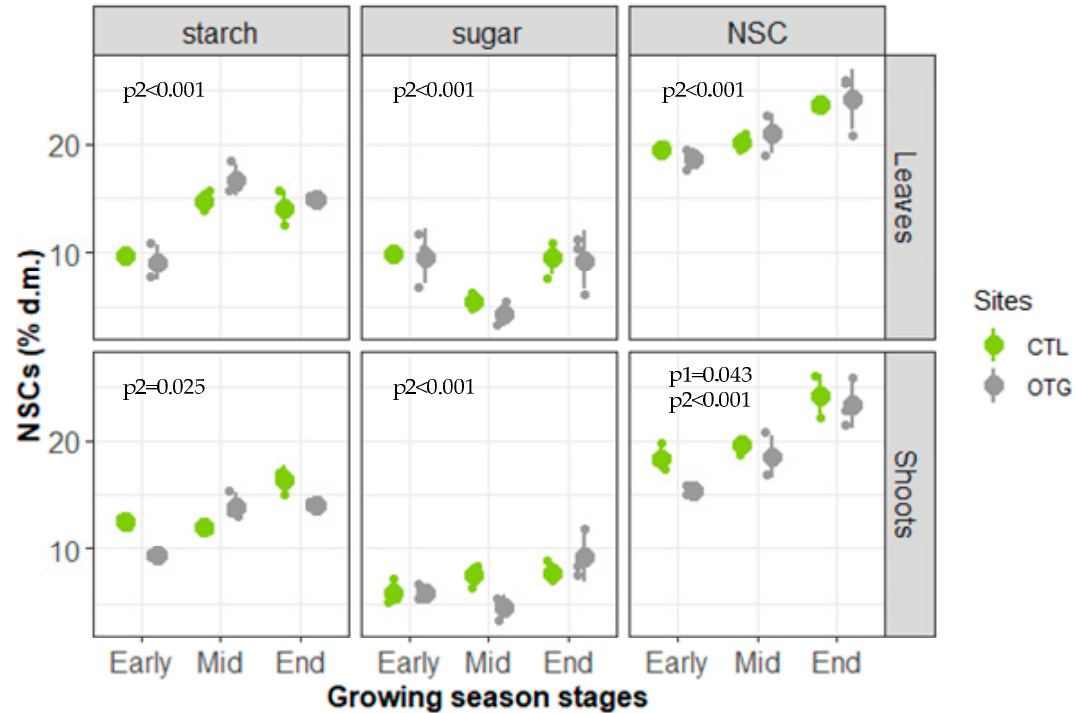
Figure 5. Non-structural carbohydrates (NSC and its components—total sugar and starch—dry mass (d.m.) fraction) (%) in leaves and shoots of Erman’s birch grown at CTL and OTG. The full data is shown on the figures, with large points show Mean ± SD. The p values from two-way ANOVA were shown in the figure, p1 represents difference between sites, while p2 represents difference between sampling stages. .